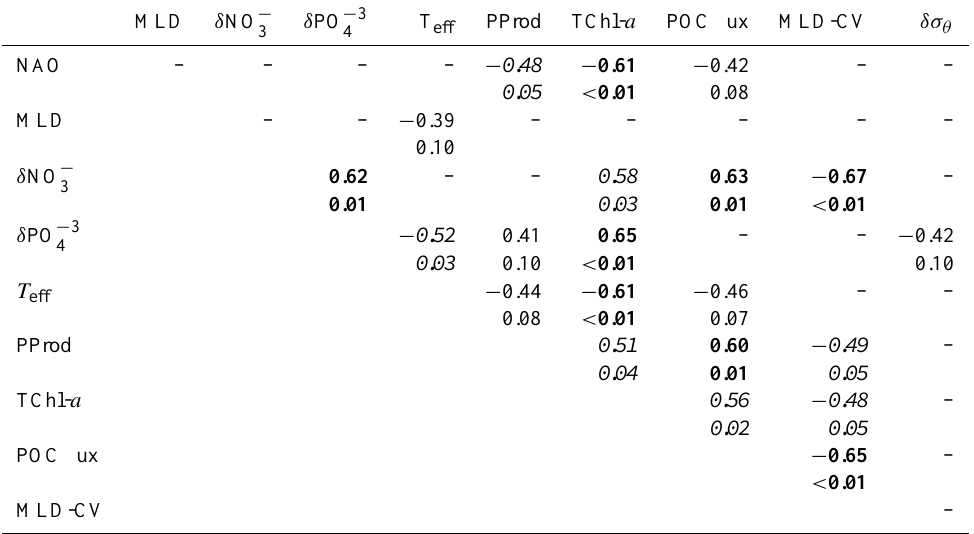
Table 2. Spearman Rank Correlation table of selected biogeochemical and environmental parameters. Within each cell, first row=correlation coefficient and second row = p-value. For each correlation, N=15 to 17. δ NO − course of the winter/spring bloom; PProd=euphotic zone integrated primary production; δσ T =difference in σ T between 200m and 5m values. All other parameters as defined in the text. Only those correlations that are P ≤ 0 . 1 are shown. P ≤ 0 . 1 – normal font, P ≤ 0 . 05 – italics, P ≤ 0 . 01 –